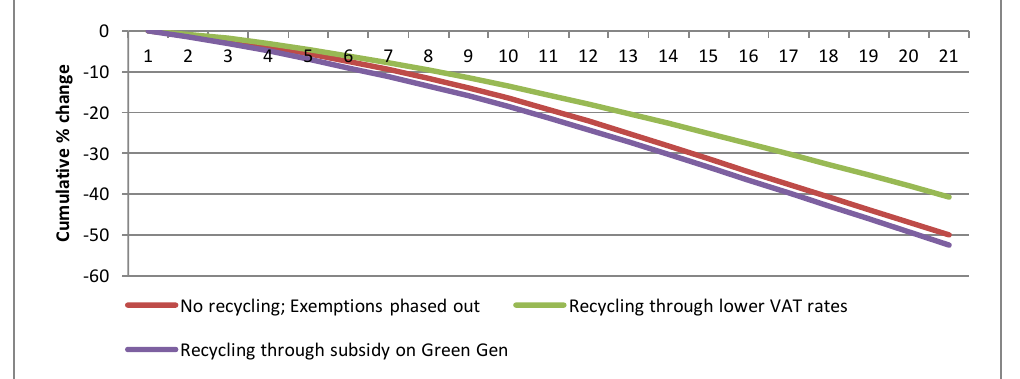
Cumulative percentage change in carbon emissions of the no-recycling scenarios compared with three recycling scenarios (deviations from the